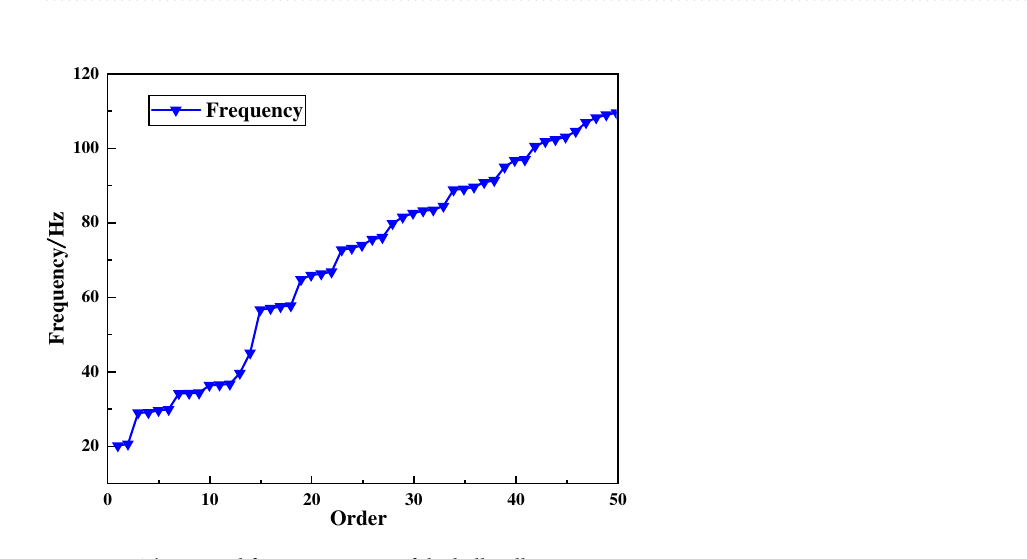
Figure 3. The natural frequency curve of the ball